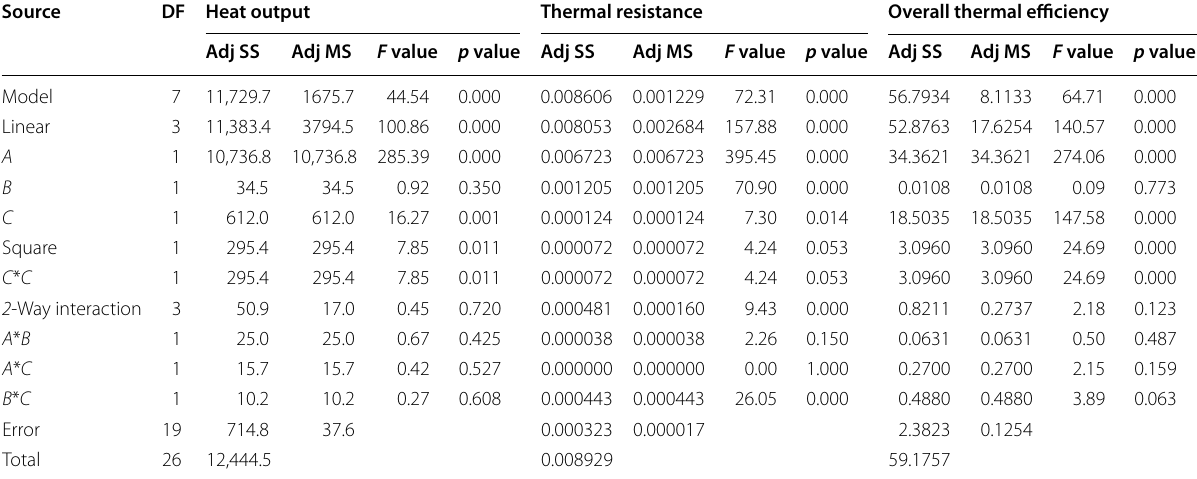
Table 5 ANOVA results of output characteristics of a V-trough absorber